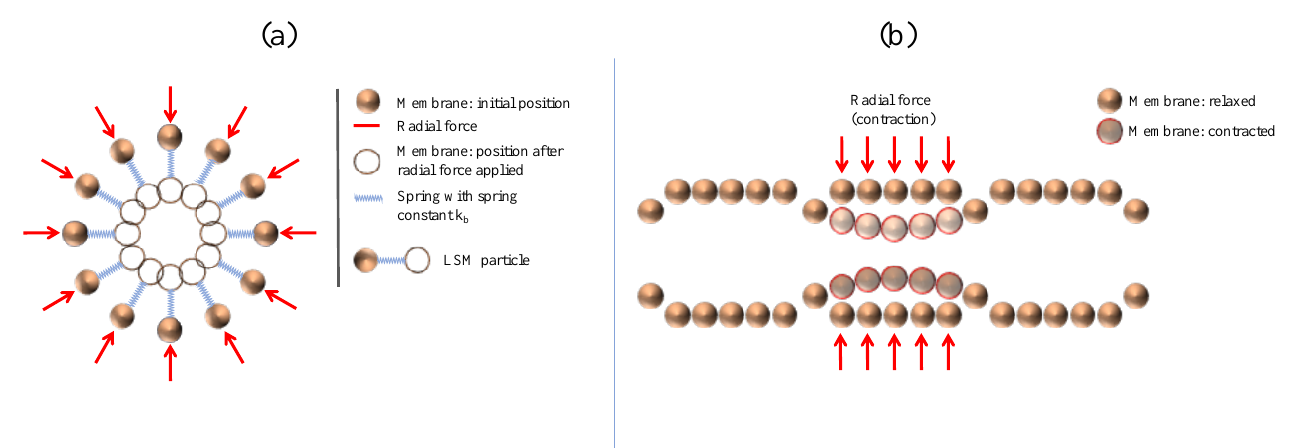
Figure 2. ( a ) 2D representation of the membrane particle anchored by a spring in equilibrium position and after the application of a radial force. ( b ) Illustration the particles representing the colon’s membrane including its characteristic haustra , before and after applying an individual radial force to each ring (‘circular muscle’).